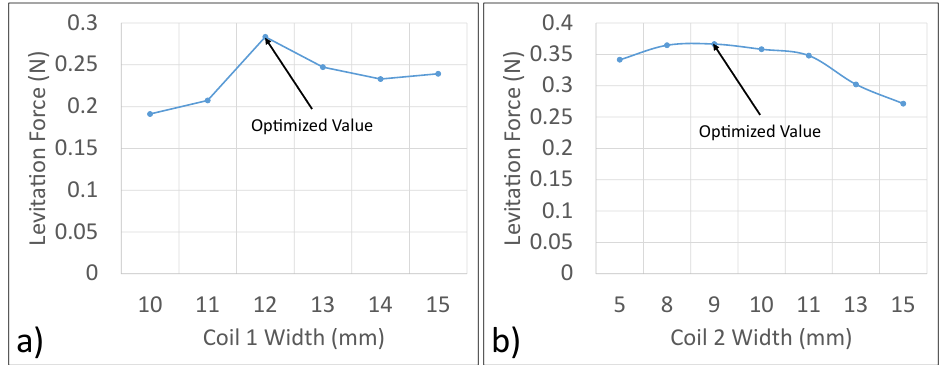
Figure 5. Optimization of the width of coils. ( a ) Optimization of the width of Coil 1. ( b ) Optimization of the width of Coil 2.